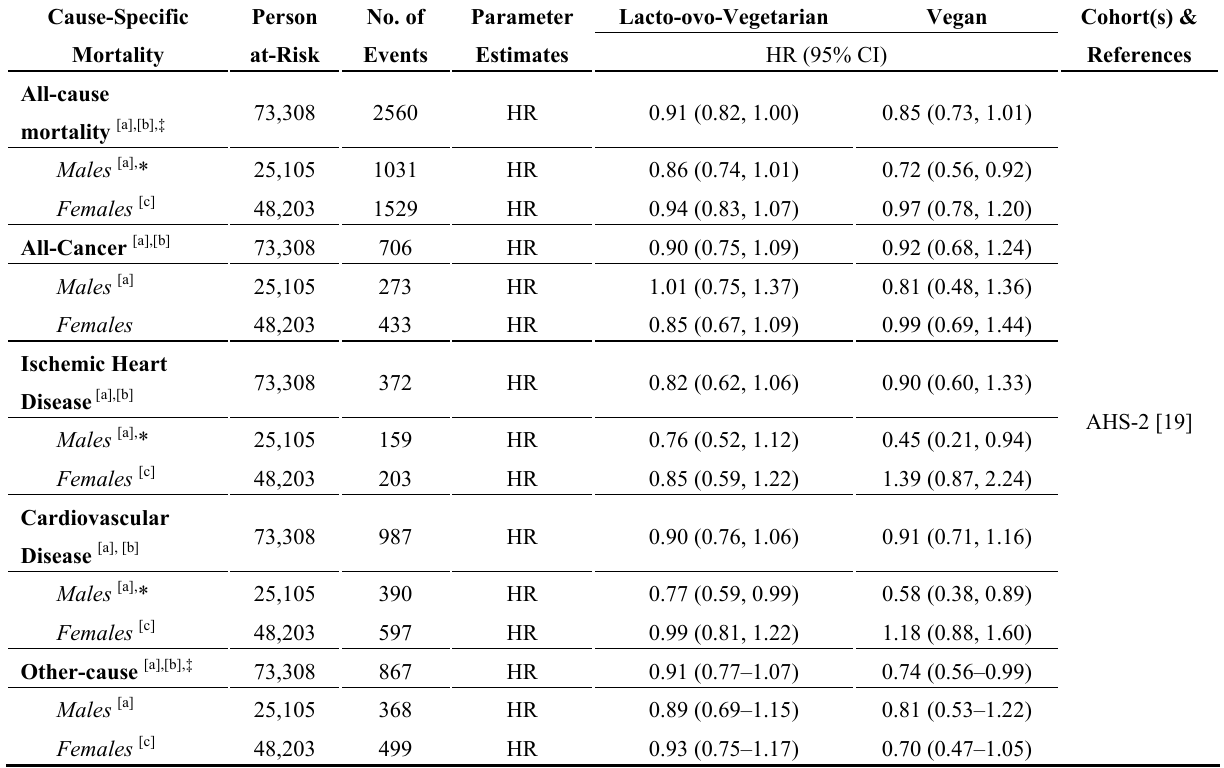
Table 8. All-cause and cause-specific mortality among lacto-ovo-vegetarians and vegan